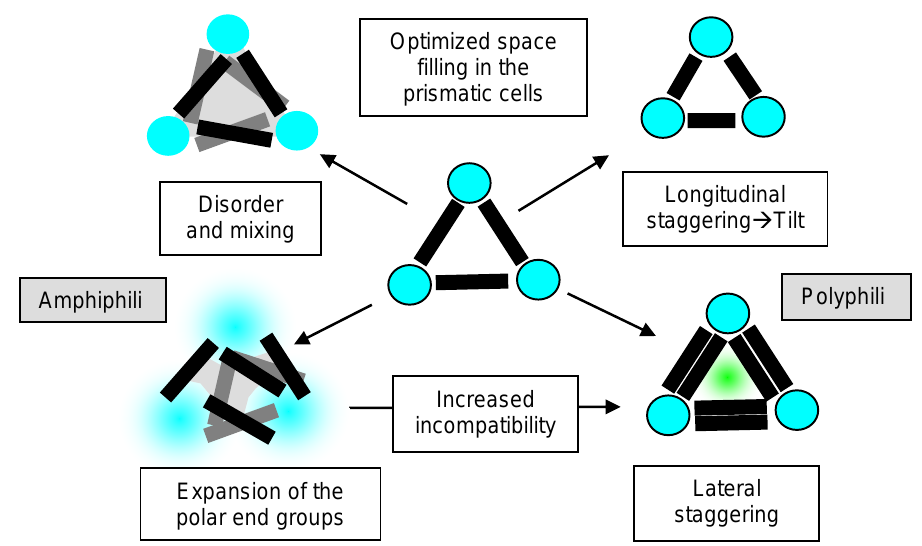
Figure 14. Transitions between polyphilic (triphilic) and amphiphilic self-assembly in the polygonal honeycomb LC phases of X-shaped bolapolyphiles, shown for the example of triangular honeycombs (see also Figure 7).